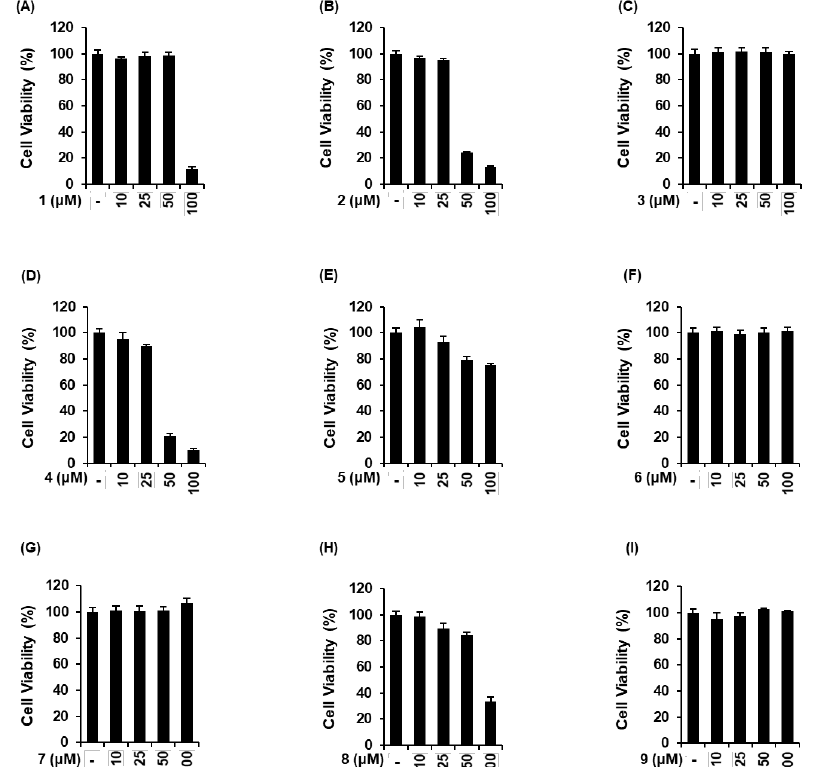
Figure 2. Comparison in the effects of 9 sesquiterpenes isolated from Artemisia argyi in LLC-PK1 cells. ( A – I ) Cells were exposed to nine sesquiterpene compounds including ( A ) moxartenolide (compound 1 ), ( B ) dehydromatricarin A (compound 2 ), ( C ) tuberiferin (compound 3 ), ( D ) argyinolide G (compound 4 ), (E) deacetylmatricarin (compound 5 ), ( F ) rupicolin A (compound 6 ), ( G ) acrifolide (compound 7 ), ( H ) 3- epi -iso- seco -tanapartholide (compound 8 ), and ( I ) iso- seco -tanapartholide (compound 9 ), and cell viability was measured using an Ez-Cytox cell viability assay kit (mean ± SD, n = 3, * p < 0.05 compared with untreated LLC-PK1 cells).